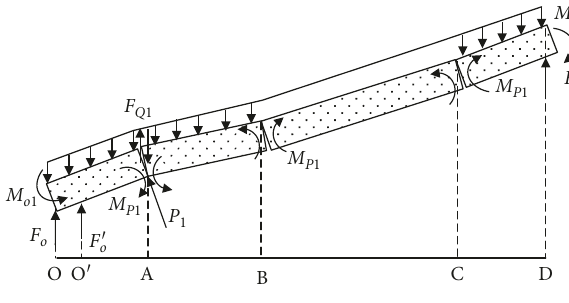
Figure 4: Failure model of beam structure.